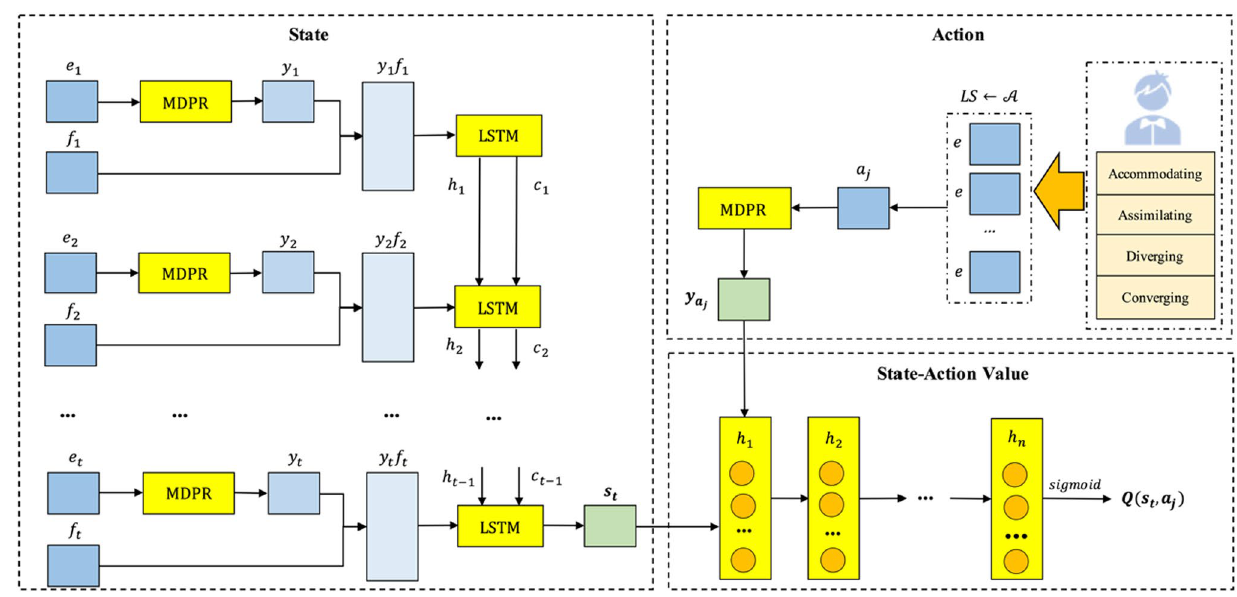
Fig. 5 PQN: the action-value Q -network of programming